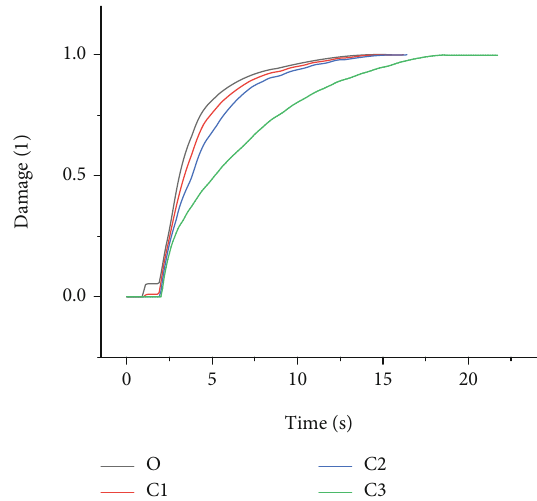
Figure 11: Damage evolution curves under di ff erent Biot coe ffi cients.